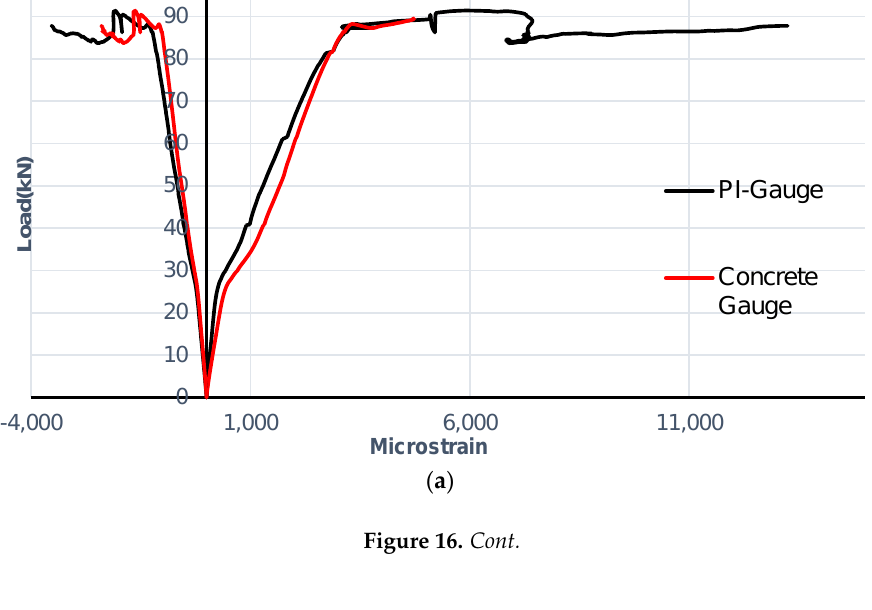
( b ) ( c ) Figure 16. Load-FRCM strain behavior at mid-span: ( a ) B4-C: PI-gauge vs. strain gauge; ( b ) Group I; ( c ) Group II.